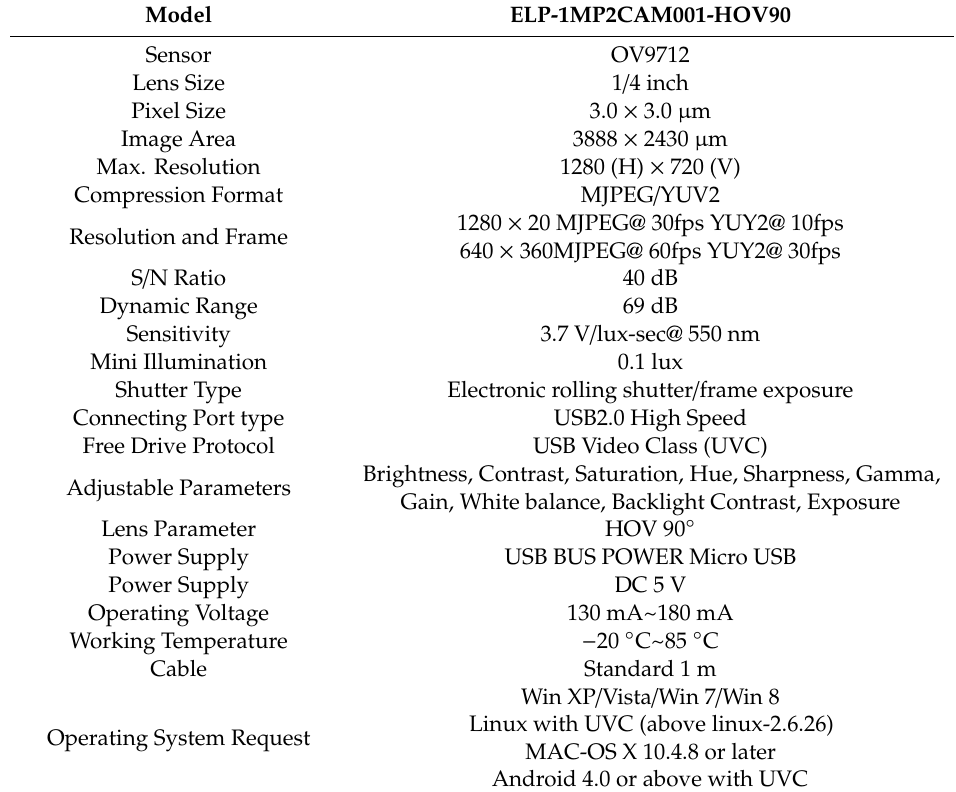
Table 2. Specifications of the dual-lens USB camera.